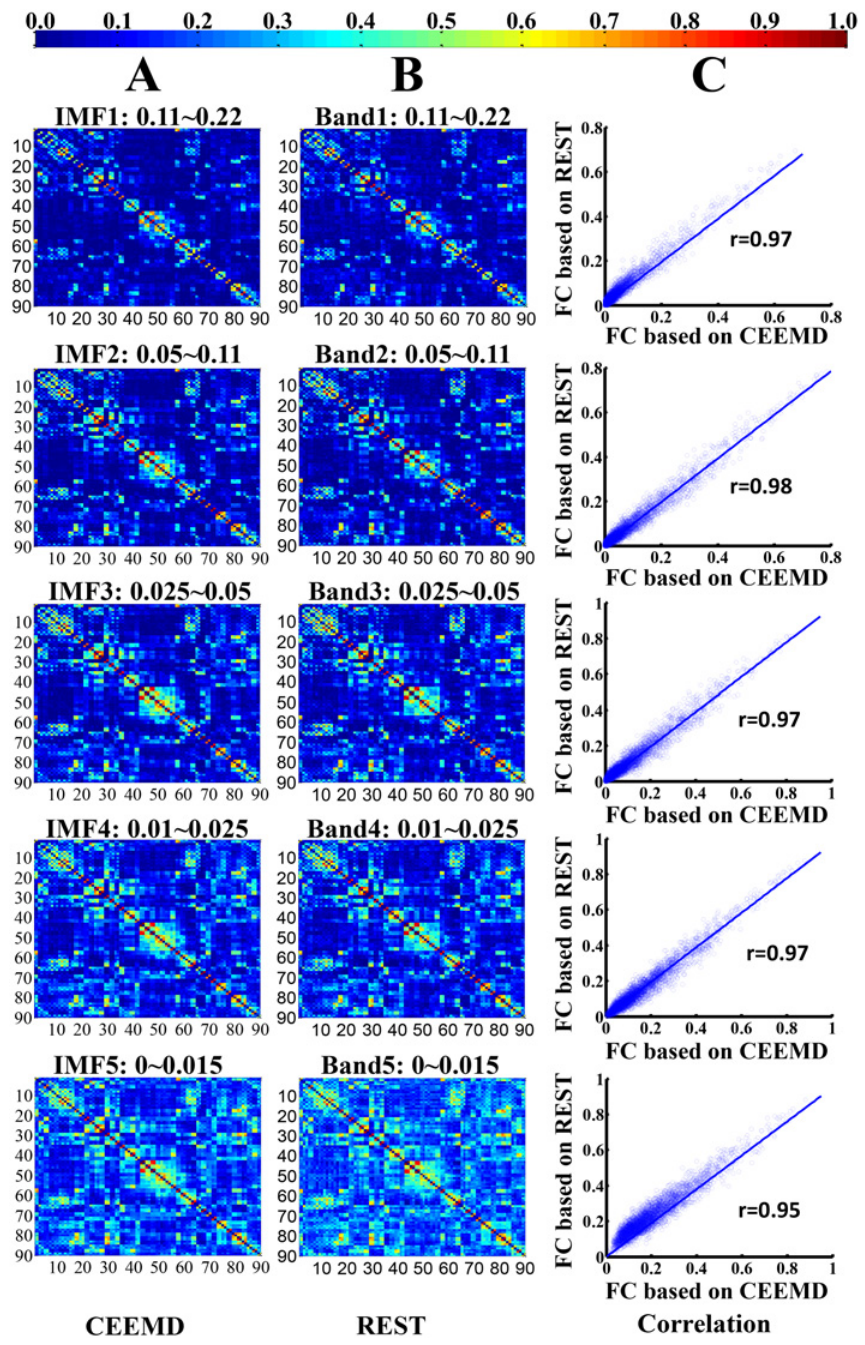
Fig 7. Comparison between the CEEMD and REST methods. (A) and (B) represent the group-mean frequency specific FC weighted networks of these two methods, namely CEEMD in current study and conventional rectangular window band-pass filter (REST), in each IMF component. (C) denotes the corresponding correlation maps between each pair of frequency specific FCNs using the two methods.